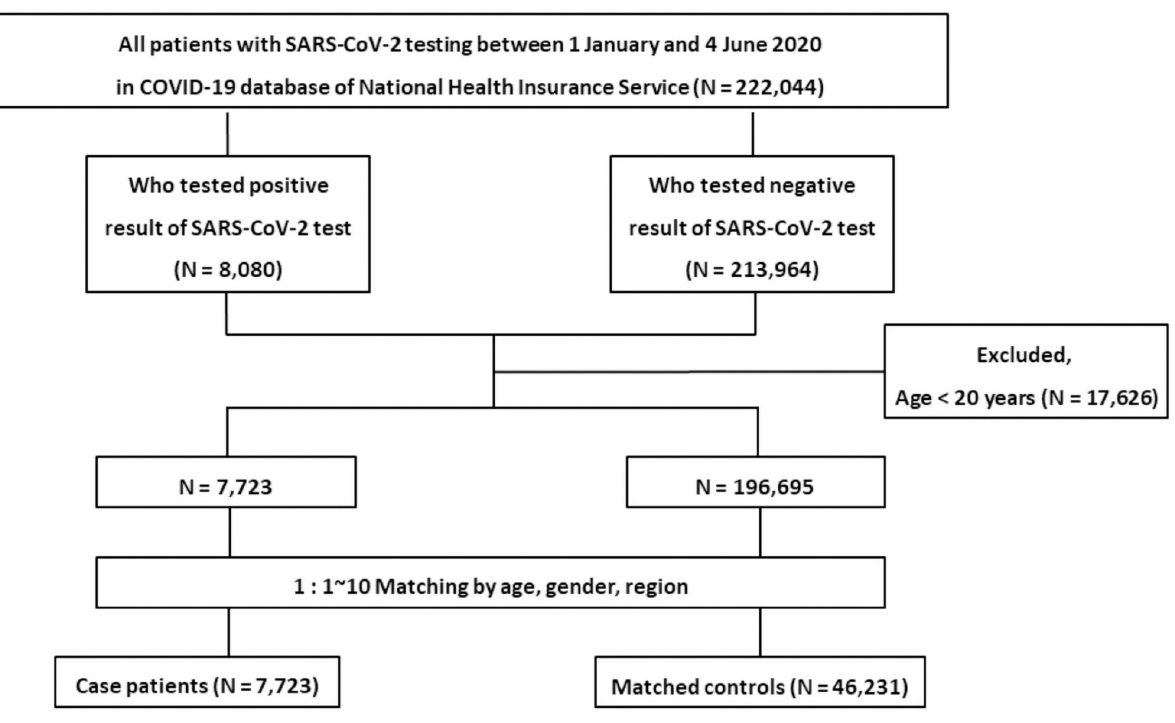
Fig 1. A flow chart of the inclusion and exclusion of patients from the Korean nationwide cohort.